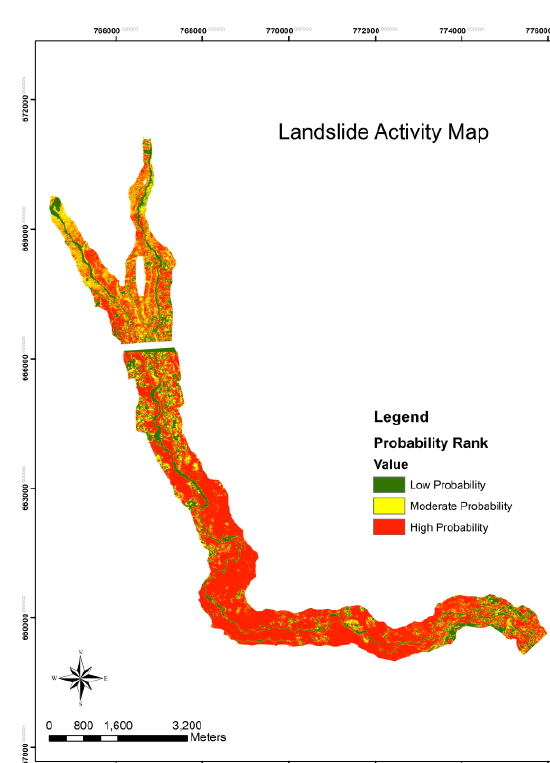
Figure 5. Dormant landslide probability map using WoE